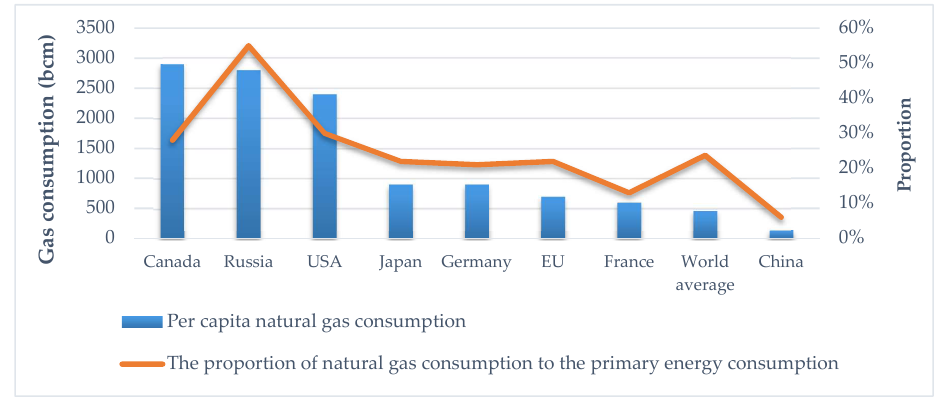
Figure 6. Per capita natural gas consumption and proportion in major countries in the world in 2014.